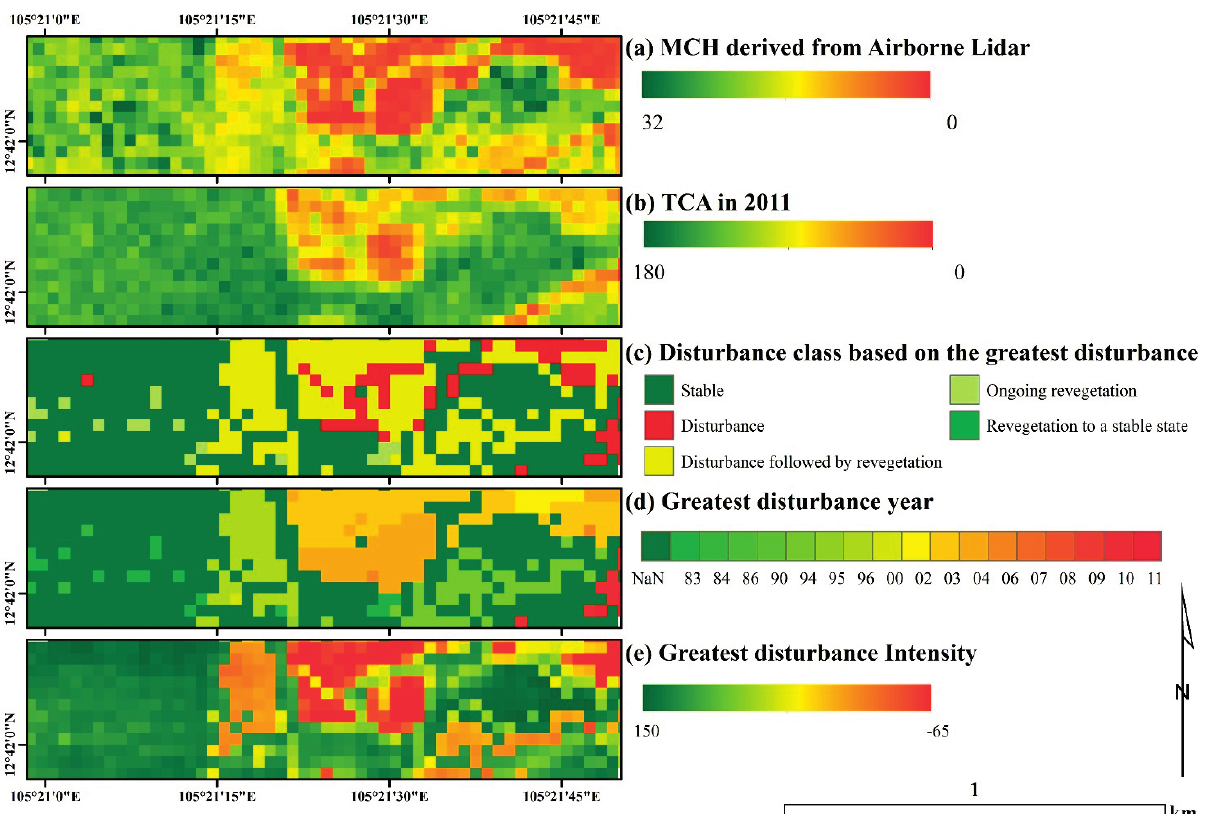
Figure 4. Examples of MCH, TCA, and out puts from trajectory-based disturbance characterization: ( a ) MCH derived from Airborne LiDAR, ( b ) TCA in 2011, ( c ) Disturbance class based on the greatest disturbance, ( d ) Greatest disturbance year and ( e ) Greatest disturbance